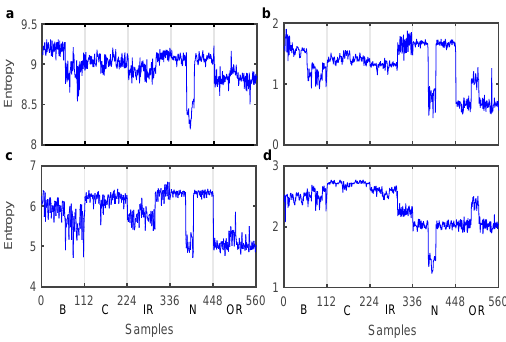
Figure 8. Four kinds of entropy features. ( a ) SSE ( b ) PSE ( c ) TFE ( d ) WPESE.